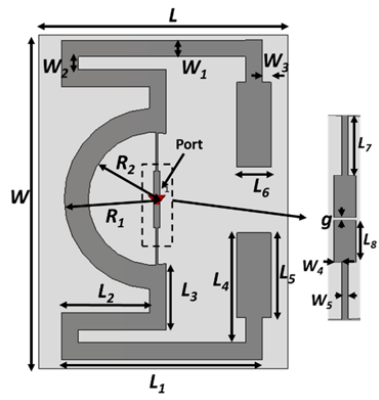
Figure 1. Design layout of the developed Flexible Radio-Frequency Identification (RFID) tag.